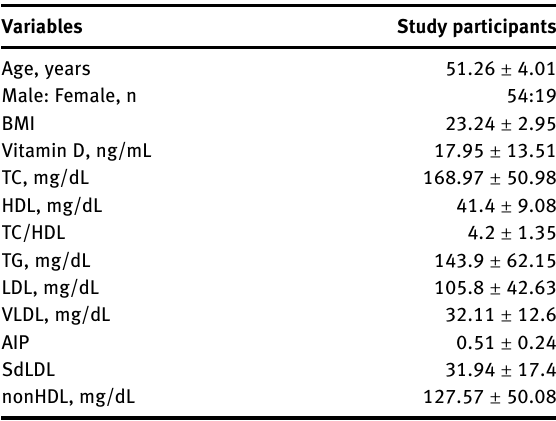
Table  : Multivariate regression model analysis of vitamin D with lipid pro fi le among total participants.